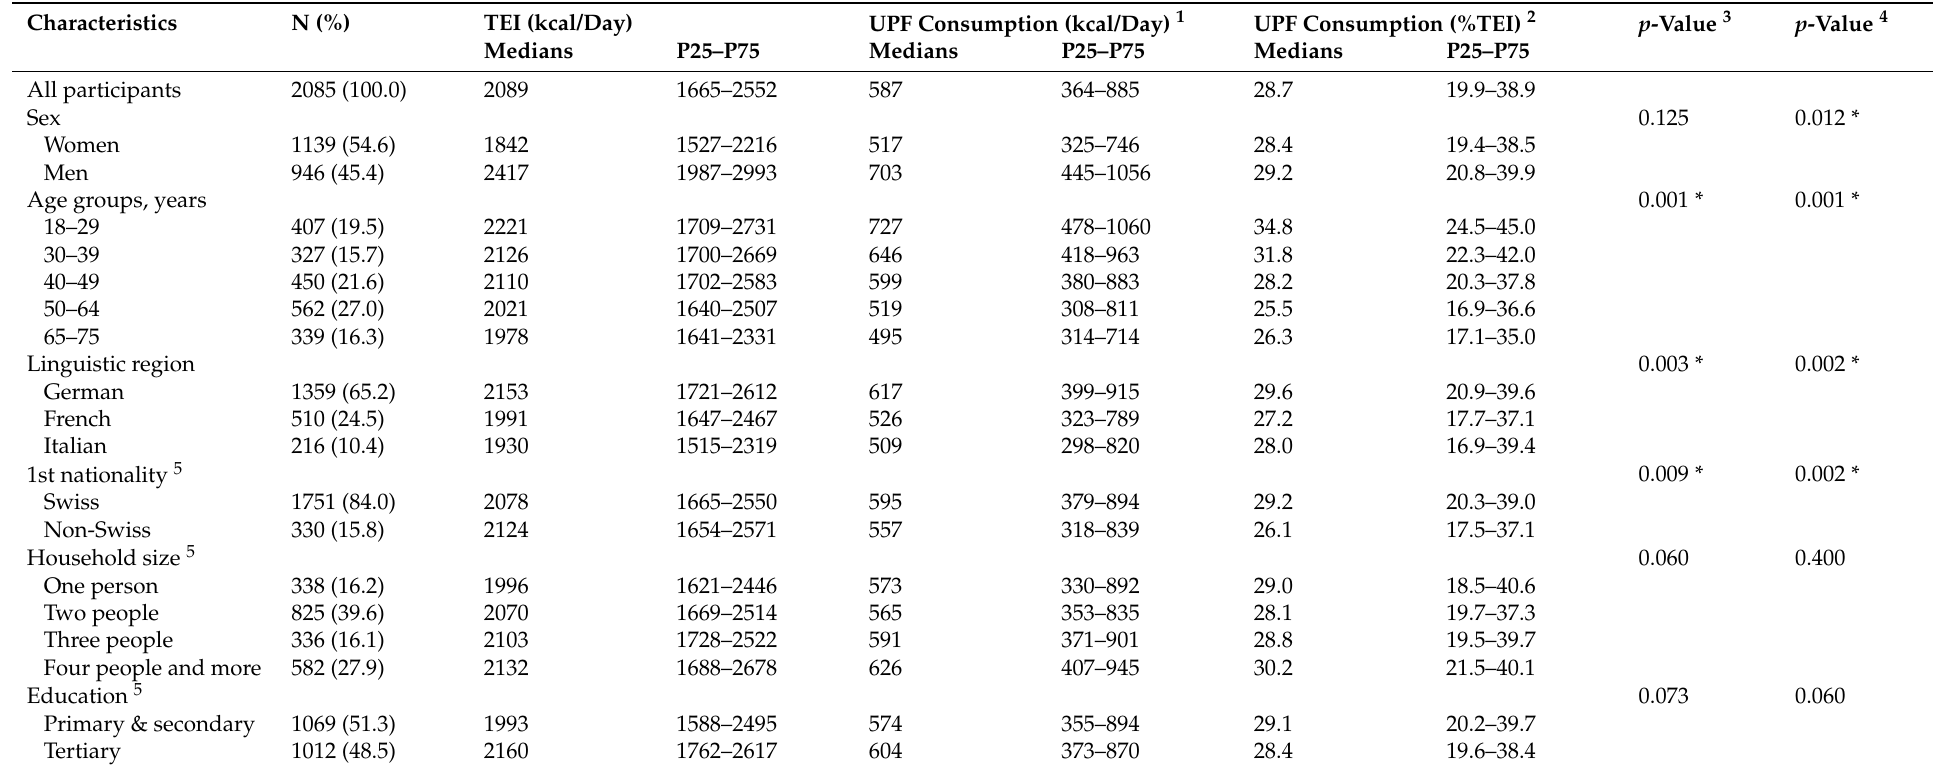
Table 1. Consumption of ultra-processed foods by sociodemographic characteristics. Swiss population aged 18 to 75 years, National Nutrition Survey